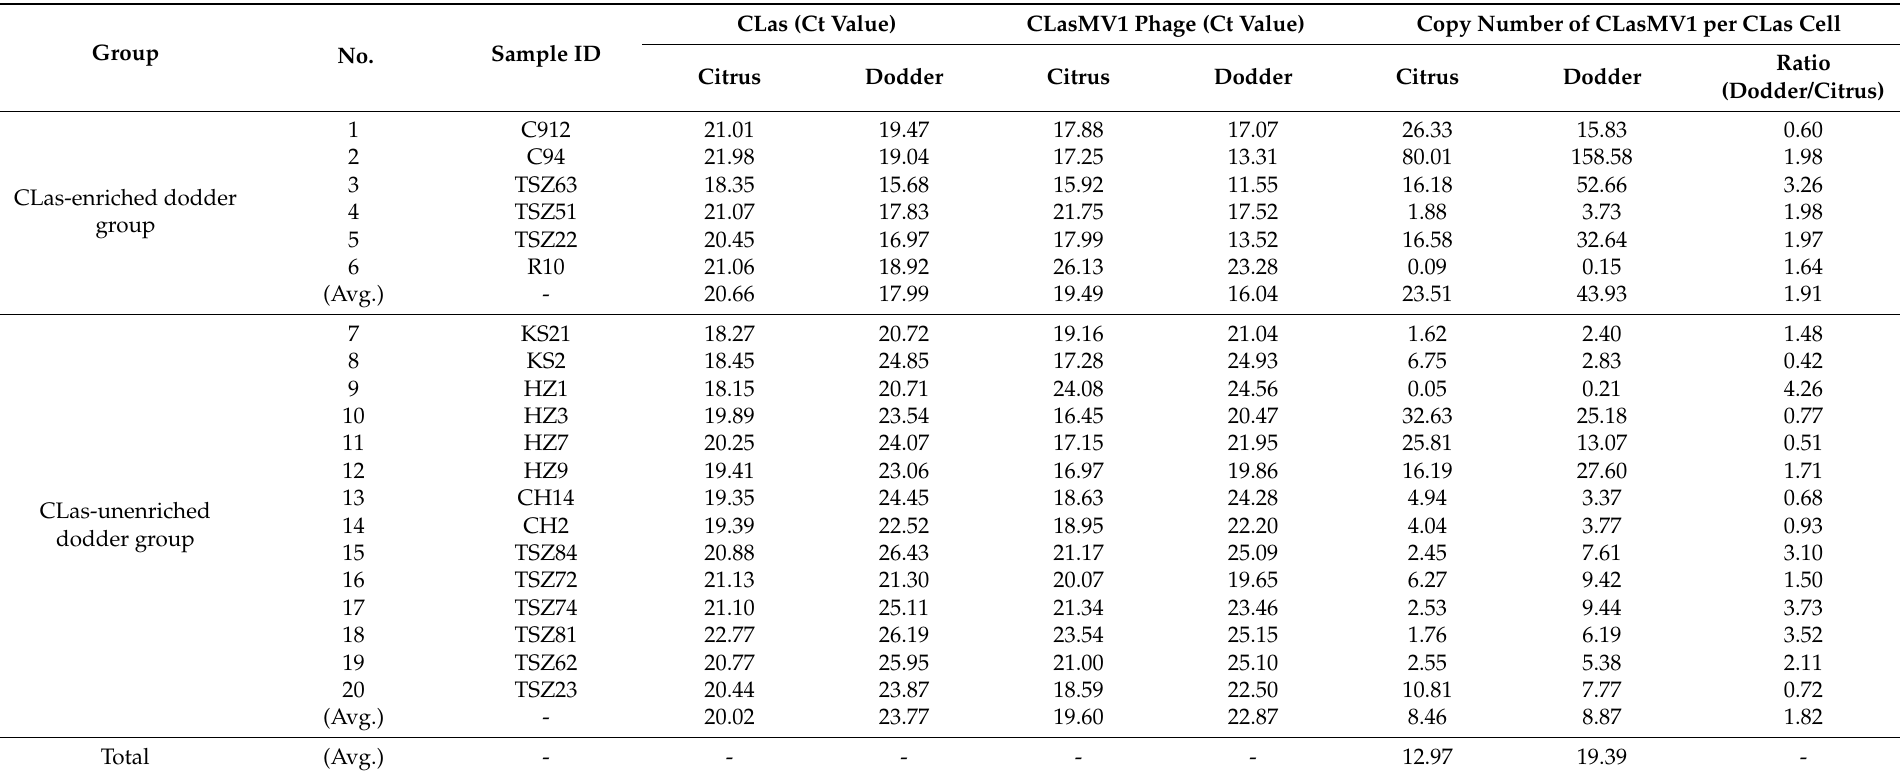
Table 2. Quantitative Real-time PCR result of “ Candidatus Liberibacter asiaticus” and CLasMV1 phage in citrus and its parasitized dodders.